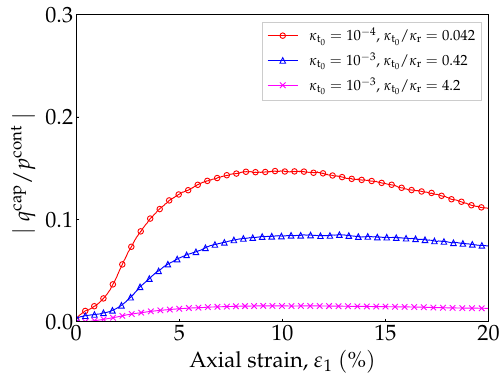
Figure 2. The evolution of deviatoric capillary stress during DEM triaxial